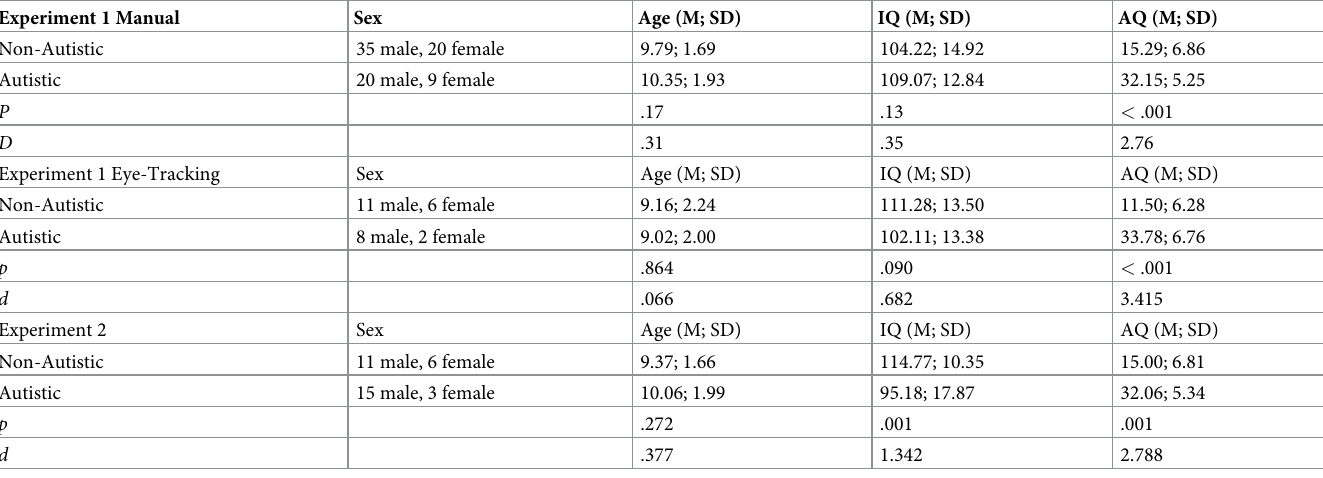
Table 1. Participant